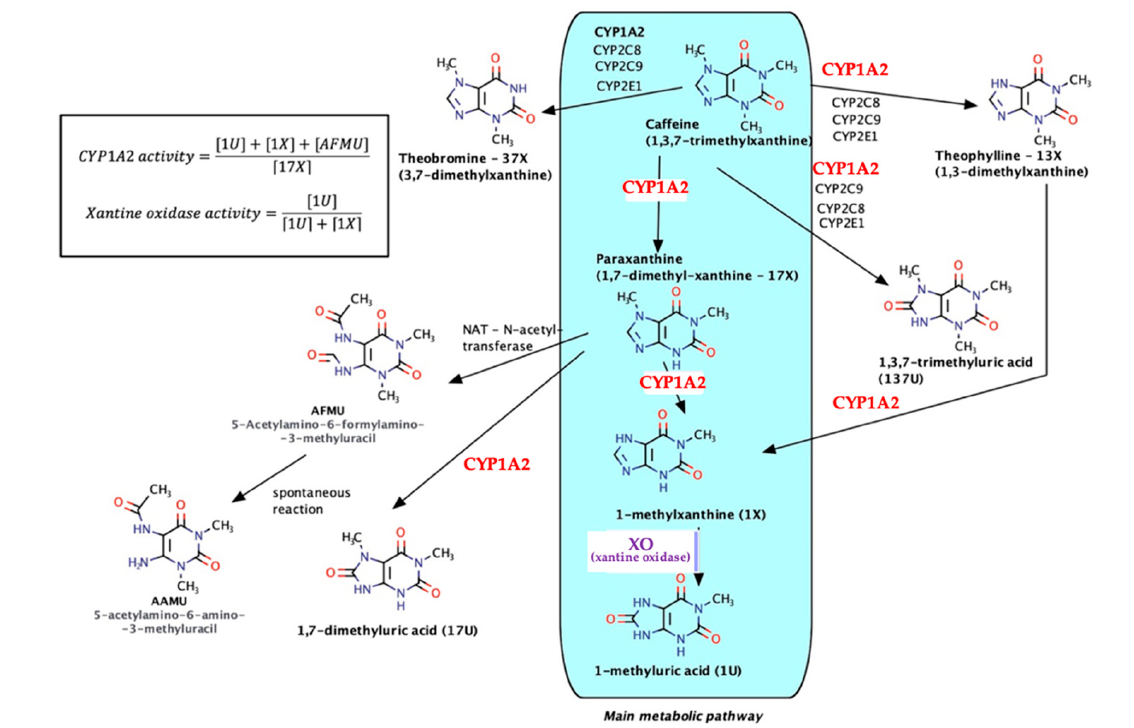
Figure 2. Caffeine metabolic pathways.